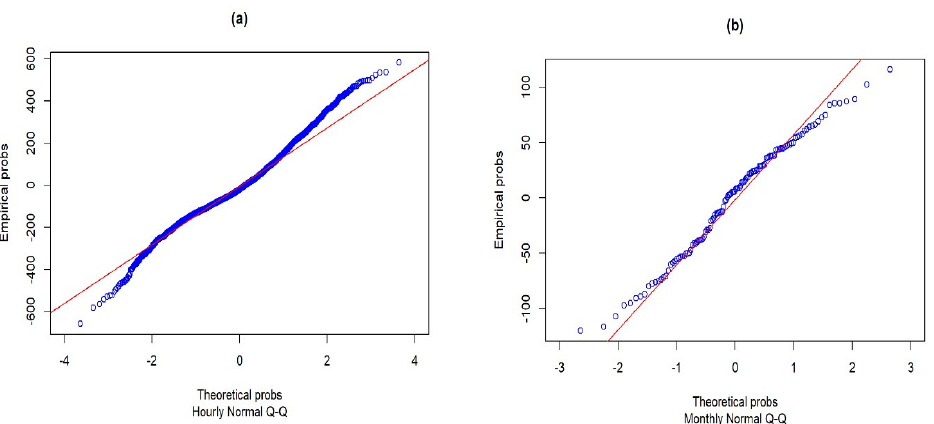
Figure 13. Normal Q-Q Plot, comparison between hourly vs. monthly GHI profiles in [W m − 2 ]. ( a ) Shows the probability of survival of the GHI data for the hourly profile, while ( b ) represents the probability of survival of GHI for the monthly profile.